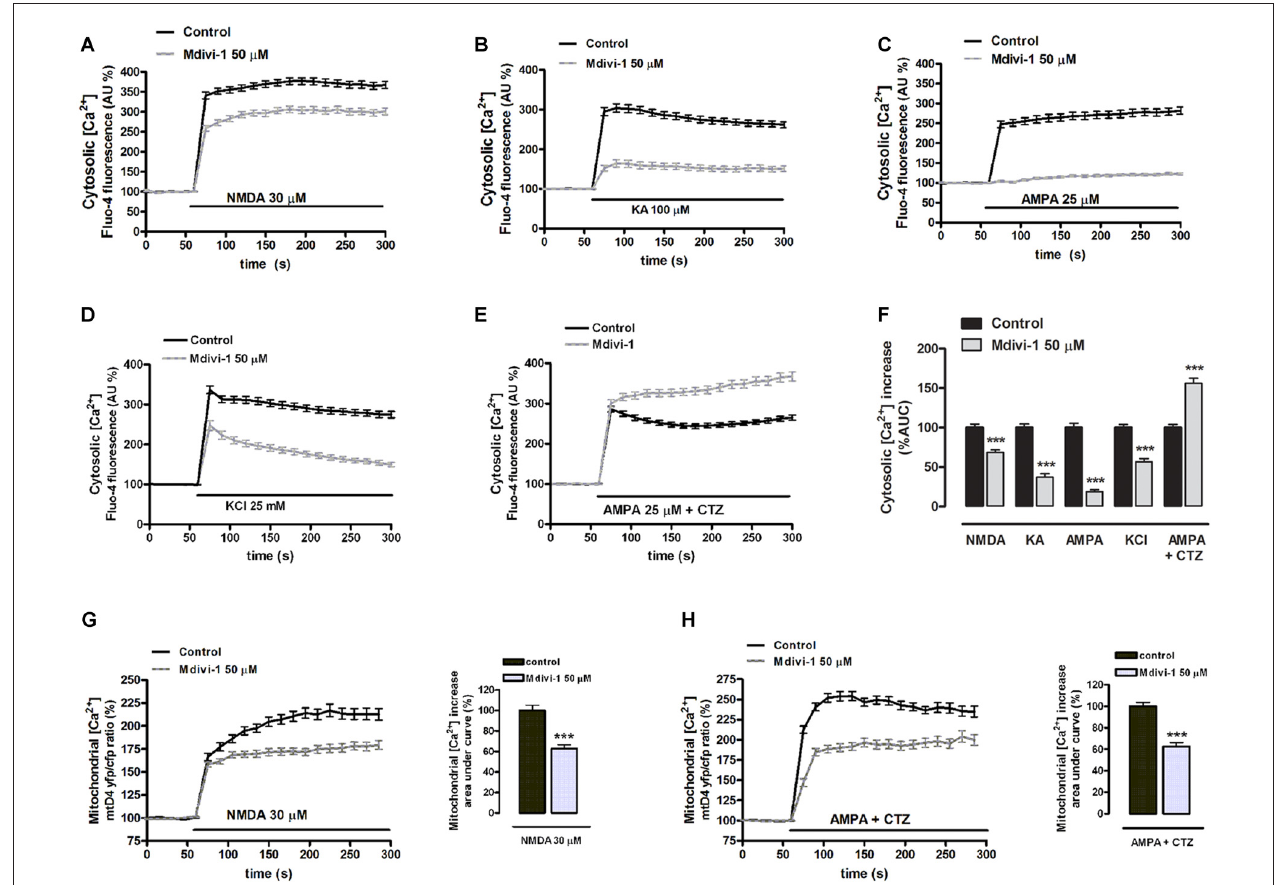
FIGURE 4 | Mdivi-1 regulates cytosolic and mitochondrial Ca 2 + overload during excitotoxicity. (A–F) Fluo-4-loaded neurons were exposed to NMDA (30 µ M), kainate (KA, 100 µ M), AMPA (25 µ M), high [K + ] and AMPA/CTZ as indicated in the absence or presence of mdivi-1 (50 µ M, 1 h) and cytosolic Ca 2 + load quantified. Traces represent normalized means ± SEM of more than 50 cells from at least three independent cultures/experiments. For statistical analysis normalized average ± SEM of the area under the curve was calculated. ∗∗∗ p < 0.001 compared to control cells (NMDA, KA, AMPA, 25 mM K + or AMPA/CTZ alone); Mann-Whitney U test. (G,H) NMDA and AMPA/CTZ were added as indicated and mitochondrial Ca 2 + levels monitored in the absence ( n = 78 and n = 50 cells) or presence ( n = 97 and n = 37 cells) of mdivi-1 (50 µ M, 1 h). Traces represent the time course of normalized yfp/cfp average ratios ± SEM of cells from at least three independent culture/experiments. For statistical analysis, normalized average ± SEM of the area under the curve was calculated. ∗∗∗ p < 0.001 compared to NMDA alone (Mann-Whitney U test), or to AMPA/CTZ alone (Student’s t